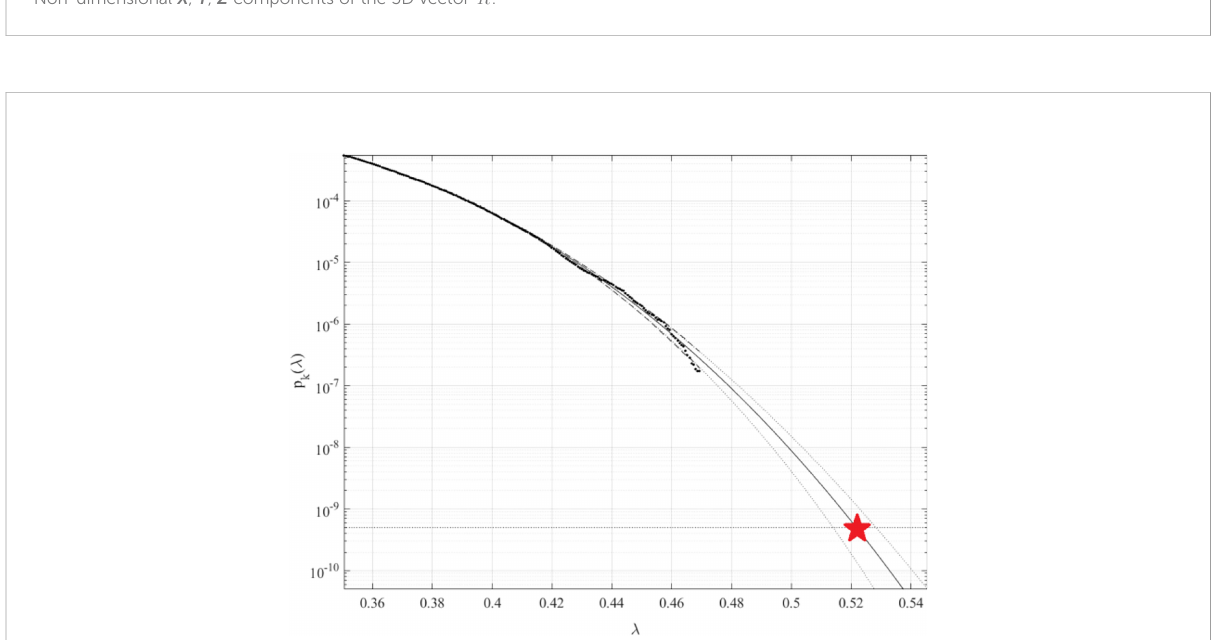
FIGURE 9 Non-dimensional X , Y , Z components of the 3D vector R